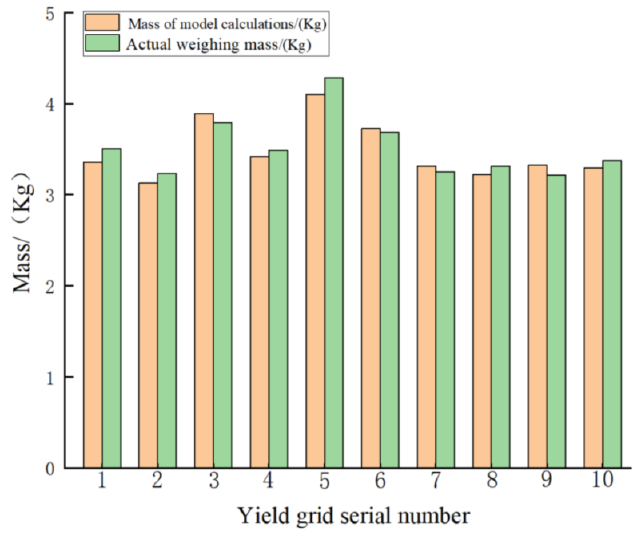
Figure 9. System real-time validation test data.